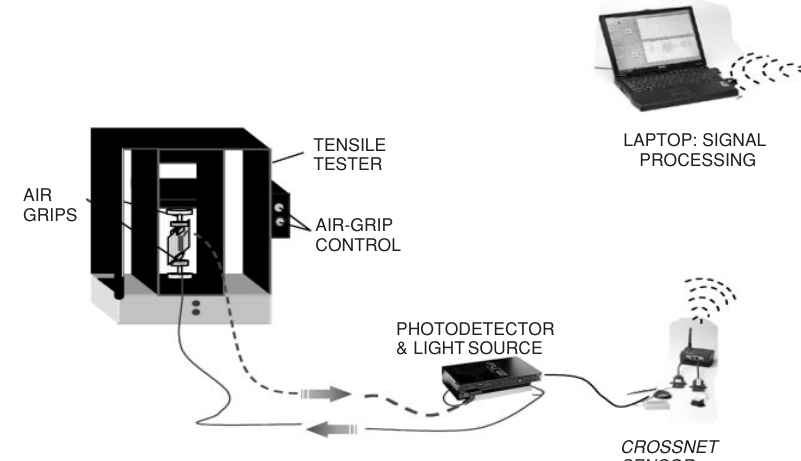
Figure 10 Smart textile with embedded MPD sensor, under quasi-static test, with remote control system.